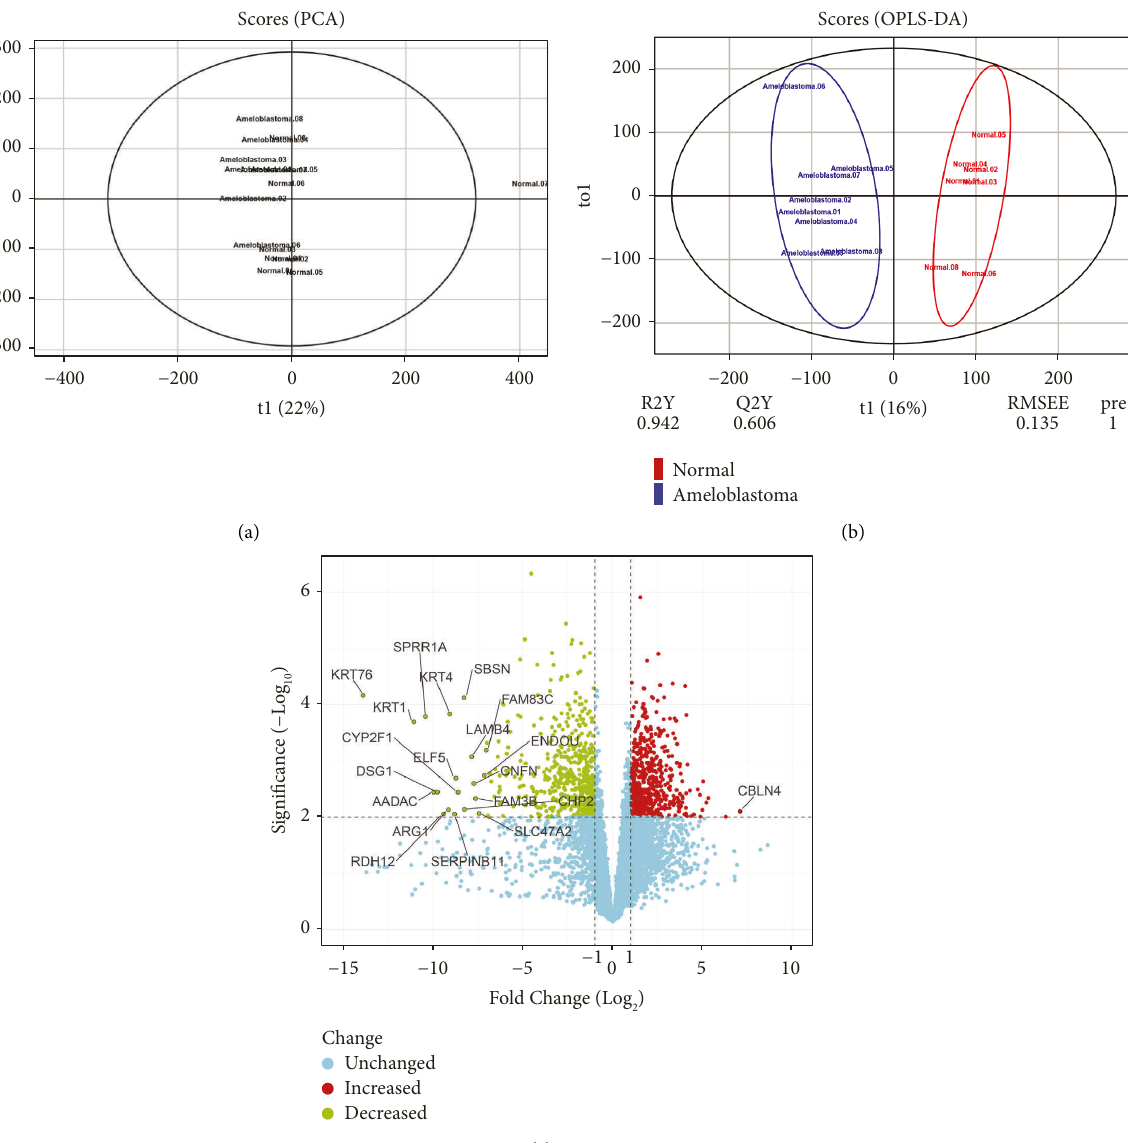
Figure 1: The score plots in the predictive ( x -axis) and orthogonal ( y -axis) components of the microarray data of the tissue samples using the (a) PCA and (b) OPLS-DA models. (c) The volcano plot of the genes in primary ameloblastoma compared with normal gingiva. PCA, principal component analysis; OPLS-DA, orthogonal projections to latent structural discriminant